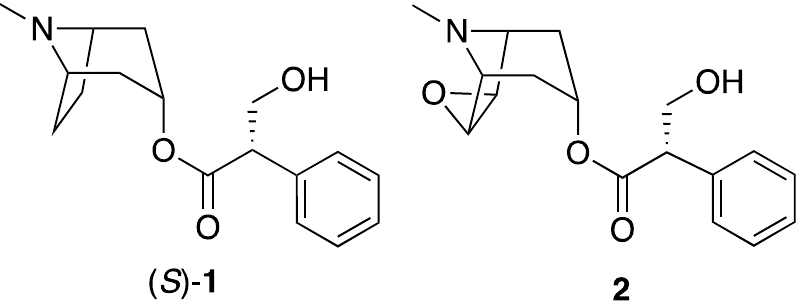
Figure 1. Hyoscyamine [( S )-1, the S -enantiomer of atropine, ( 1 ) and scopolamine ( 2 ), the most well-known alkaloids of the genus Datura .